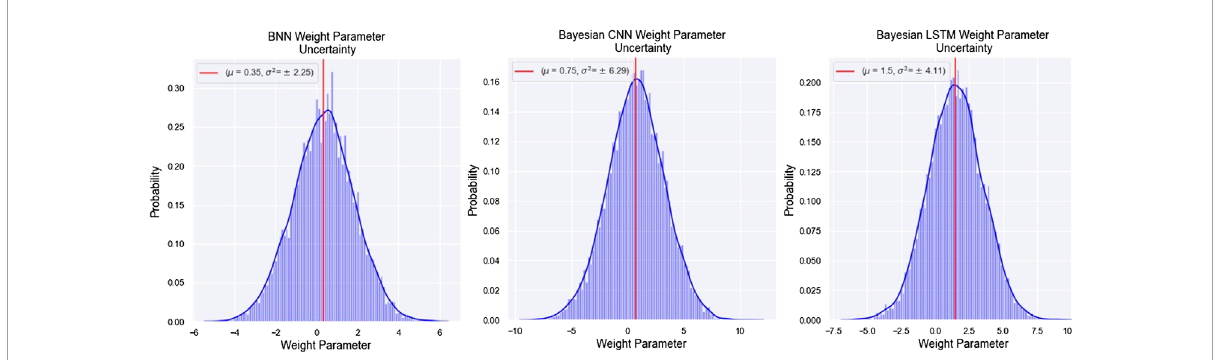
FIGURE 2 Instances of Posterior Weight Distribution For The Three Unit Models- BNN, Bayesian CNN, and Bayesian LSTM. Each Distribution is Labelled With Their Respective Mean and Variance.